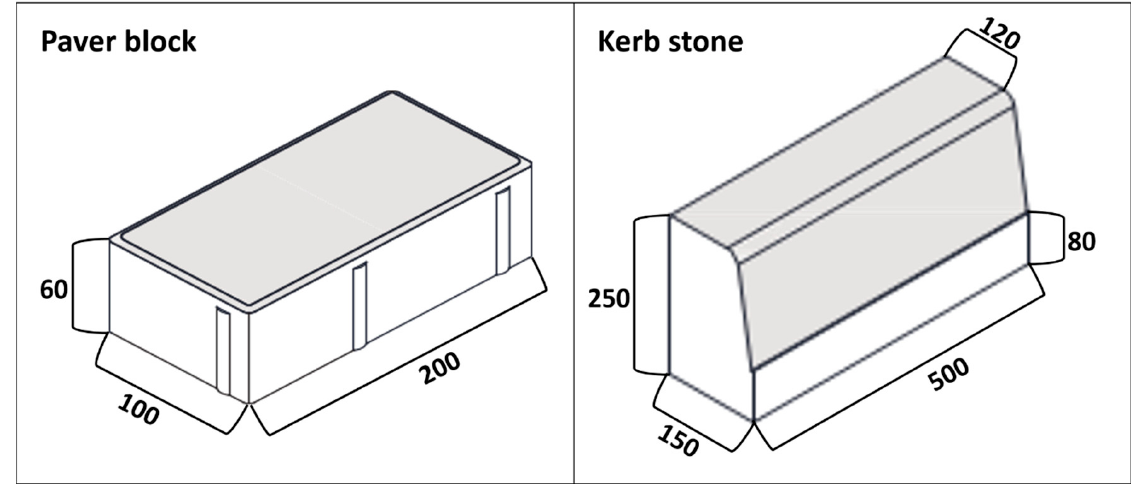
Figure 1. General appearance and dimensions (mm) of the paving blocks ( left ) and the kerbstone ( right ).